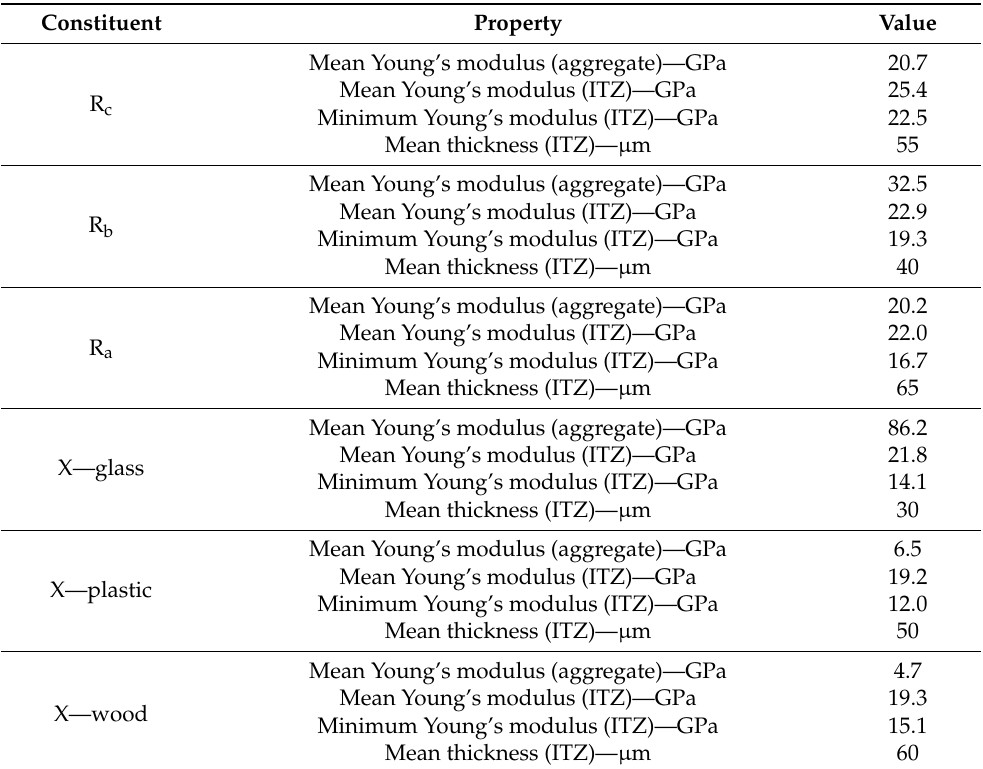
Table 2. Results of nanoindentation tests on constituents of CRA, including the ITZ [19].